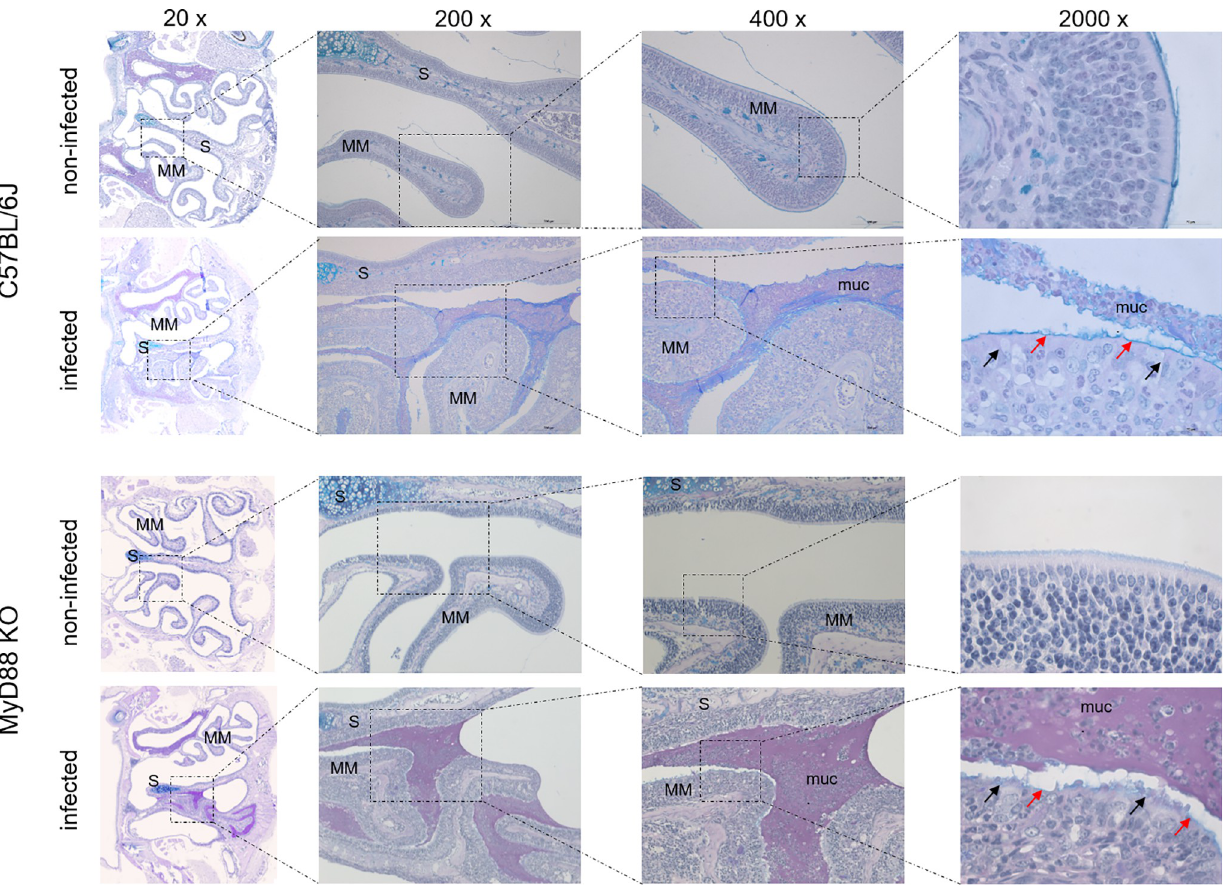
Fig 9. The B . pertussis -infected nasal cavity is filled by large amounts of mucinous exudate. Periodic Acid Schiff–Alcian Blue staining for mucus. Representative images of stained level 2 coronal sections through the nasal cavity of MyD88 KO and C57BL/6J mice on day 7 after inoculation of nares with 5 μ l of suspension containing 10 7 or 10 9 CFU of B . pertussis bacteria, respectively. The olfactory epithelium and the nasal septum of infected mice is covered with a thick layer of mucus (muc) filling the cavities as mucopurulent exudate. Turbinates of the infected animals exhibit signs of atrophy. The red arrows point to the disrupted/denuded layer of olfactory epithelia that lost cilia. The black arrows point to the Goblet cells in the olfactory epithelium with massive mucus production. 3 mice per group were used and representative images of stained sections are shown.